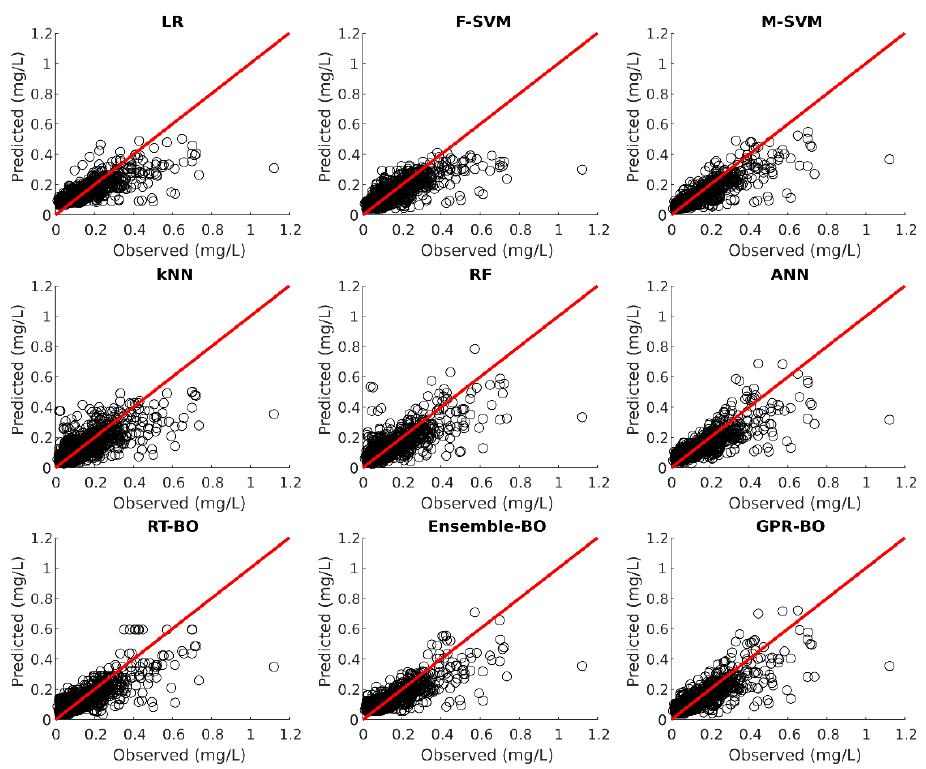
Figure 10. Observed versus predicted daily phosphorus concentration for Maumee using different ML.